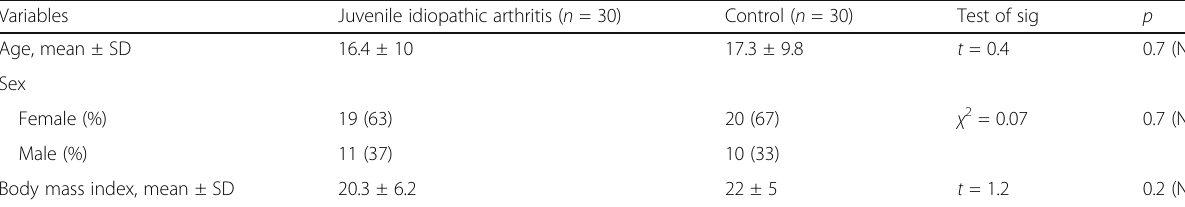
Table 1 Demographic data of the studied groups